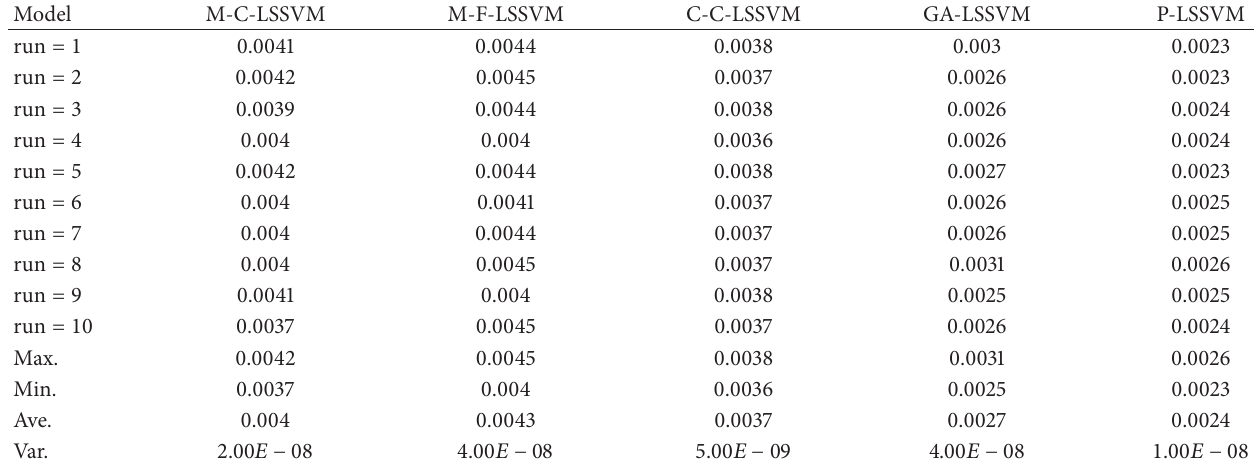
Table 6: Five models predicted error based on RMSE for interphone band.